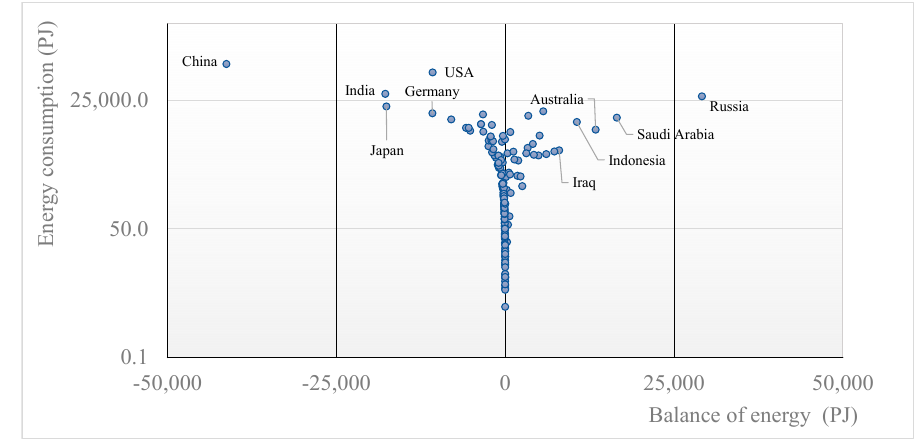
Figure 3. Production of primary energy vs. energy consumption in di ff erent countries (2019).